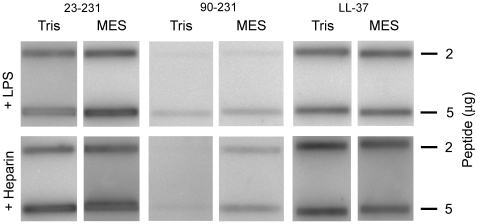
Interactions of PrP with LPS and heparin.2 and 5 µg of recPrP and the truncated PrP90–231 were applied onto nitrocellulose membranes, followed by incubation with iodinated (125I) heparin or LPS in either Tris pH 7.4 or MES pH 5.5 (all at 10 mM, with 0.15 M NaCl). Radioactivity of bound heparin or LPS was visualized using a phosphorimager system. LL-37 is included for comparison.